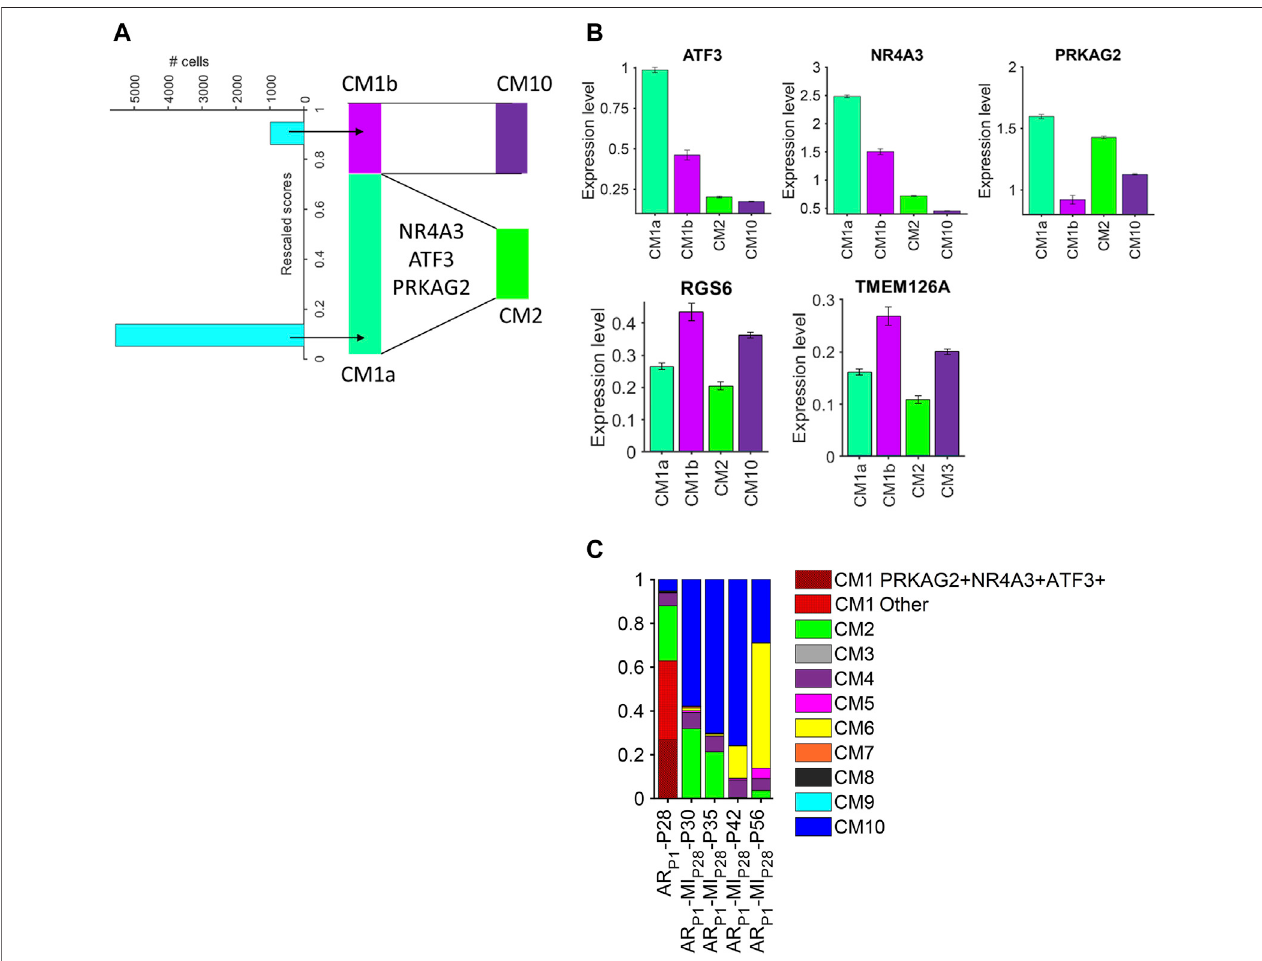
FIGURE 5 | Cardiomyocytes in the CM1 cluster could be partitioned into CM2- and CM10-like subpopulations. (A) snRNA-seq data for CM1 cardiomyocytes in AR P1 -P28 hearts and for CM2 and CM10 cardiomyocytes in AR P1 MI P28 -P30 hearts were evaluated with a semisupervised learning model to calculate a rescaled score for each CM1 cardiomyocyte. Cardiomyocytes with rescaled scores approaching 0 were designated CM1a (CM2-like) and cardiomyocytes with rescaled scores approaching 1 were designated CM1b (CM10-like). (B) The abundance of ATF3, NR4A3, PRKAG2, RGS6, and TMEM126A RNA transcripts was measured in CM1a, CM1b, CM2, and CM10 cardiomyocytes. (C) The proportion of PRKAG2+NR4A3+ATF3+ cardiomyocytes in CM1 (AR P1 -P28), in comparison with CM2